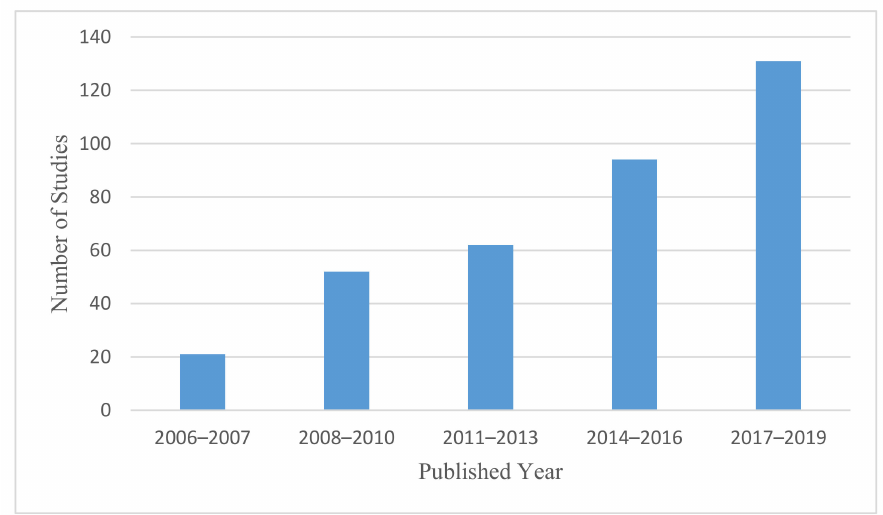
Figure 3. Chronological distribution of reviewed articles.